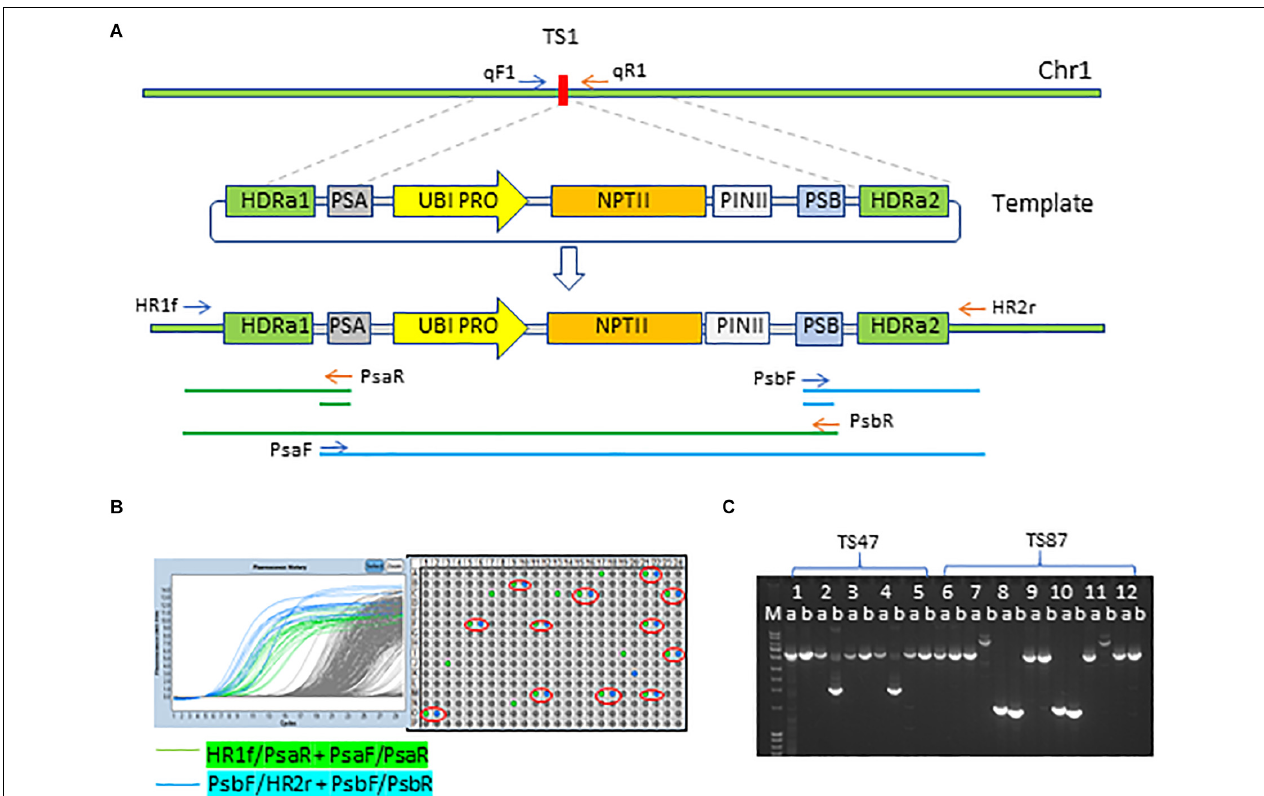
FIGURE 3 | Insertion of SSI landing pad to CRISPR-Cas9 target site. (A) Insertion of SSI landing pad (SSILP) into CRISPR-Cas9 target site 1 (TS1) on chromosome 1 (Chr 1). UBI PRO, maize UBIQUITIN1 promoter; NPTII, neomycin phosphotransferase II; PINII, potato proteinase inhibitor II terminator; HDRa, homology-directed repair arm; PSA and PSB, unique sequences to facilitate high-throughput screening for insertion events. HR1f, HR2r, PsaR, PsaF, PsbF, and PsbR are PCR primers and arrows indicate the direction of primers. (B) Screening of T0 plants for insertion events with PCR and qPCR. The plants positive for both junctions are indicated in red circles. (C) Image of agarose gel showing overlapping long PCR products for two SSILP insertion sites (TS47 and TS87). Lane a, PCR products amplified with primers HR1f and PsbR; Lane b, PCR products amplified with primers PsaF and HR2r; Lane M, molecular-weight size markers. PCR products of the sample 1, 3, 5, 6, 9, and 12 have expected